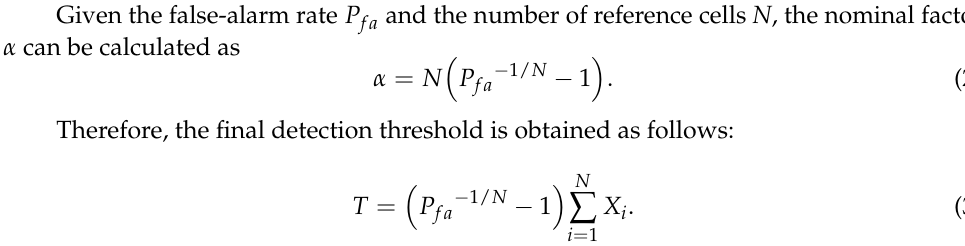
Figure 1. Cell average constant false-alarm rate (CA-CFAR)